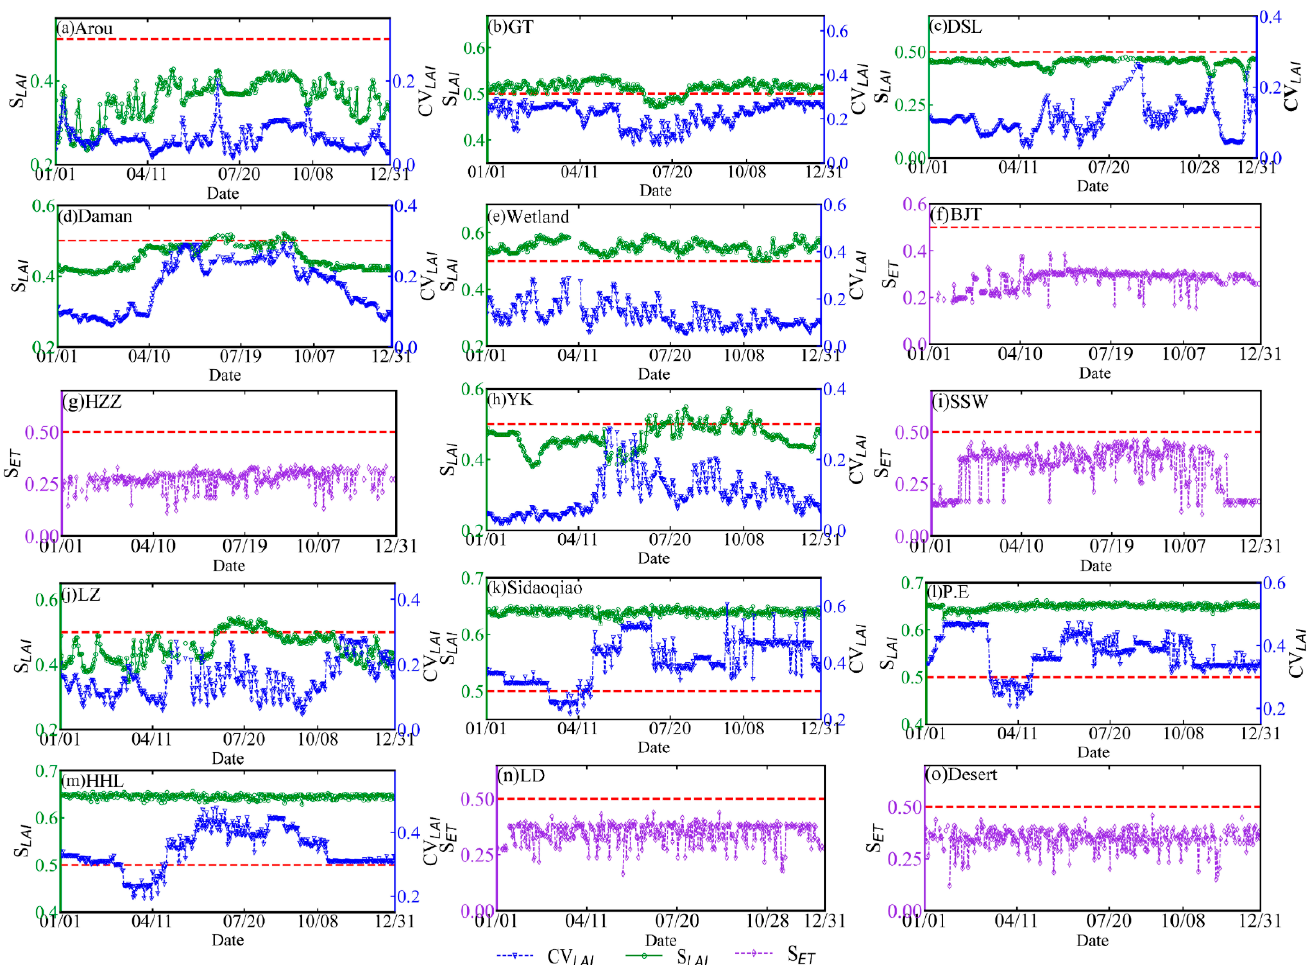
Figure 3. The assessment results of the spatial heterogeneity of the LSHCs. ( a – o ) correspond to the Arou, GT, DSL, Daman, Wetland, BJT, HZZ, YK, SSW, LZ, Sidaoqiao, P.E, HHL, LD, and Desert stations, respectively. The red horizontal line represents the threshold line of the evaluation scheme.